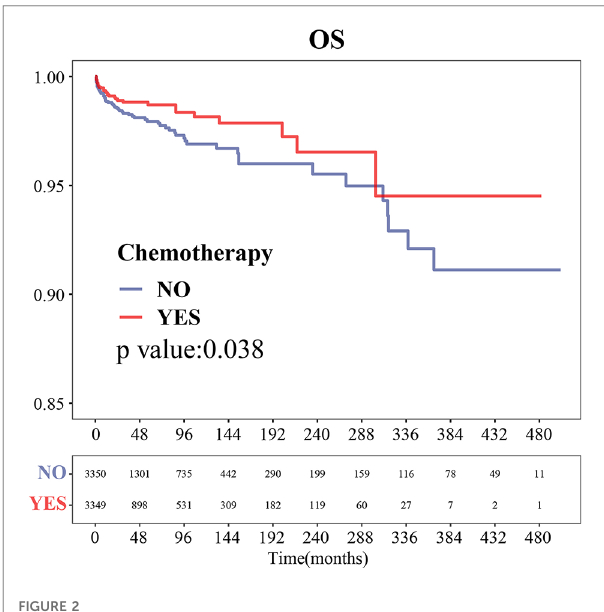
FIGURE 2 Cardiac disease-speci fi c survival curve of chemotherapy after